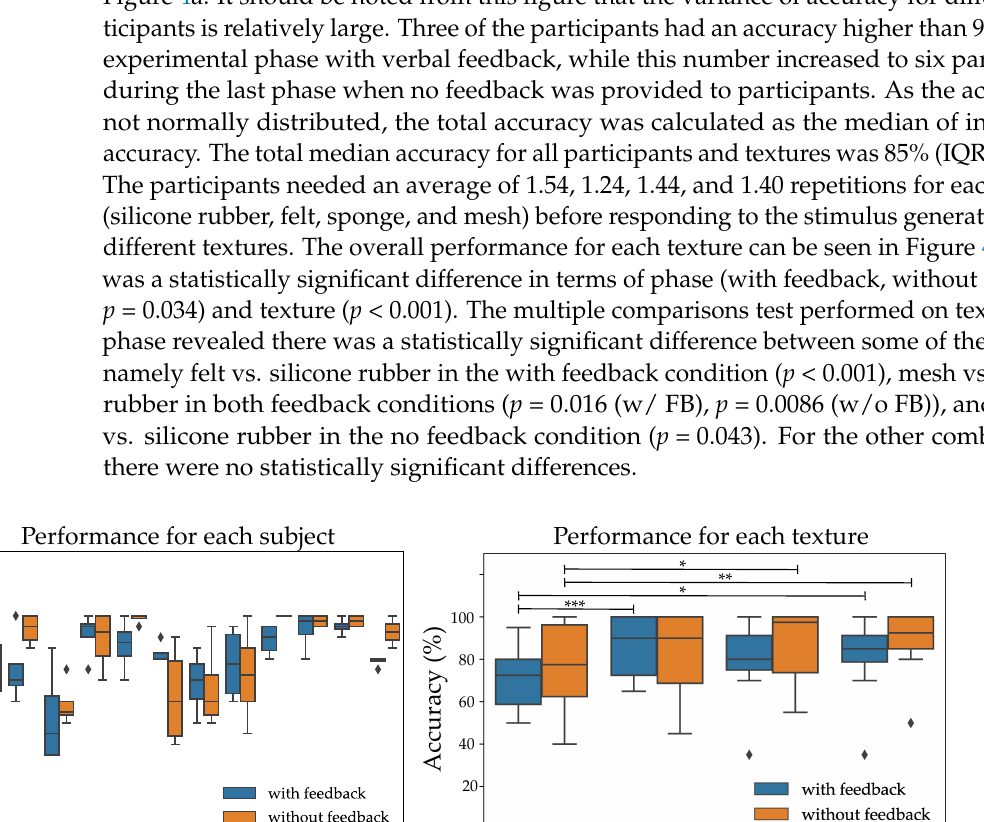
Figure 5. During the final phase (without feedback) the median performance for each texture: Silicone rubber, felt, sponge, and the mesh was 77.5% (IQR 62.50–96.25), 90% (IQR 68.75–100.00), 97.5% (IQR 73.75–100.00), and 92.5% (IQR 85.00–100.00),